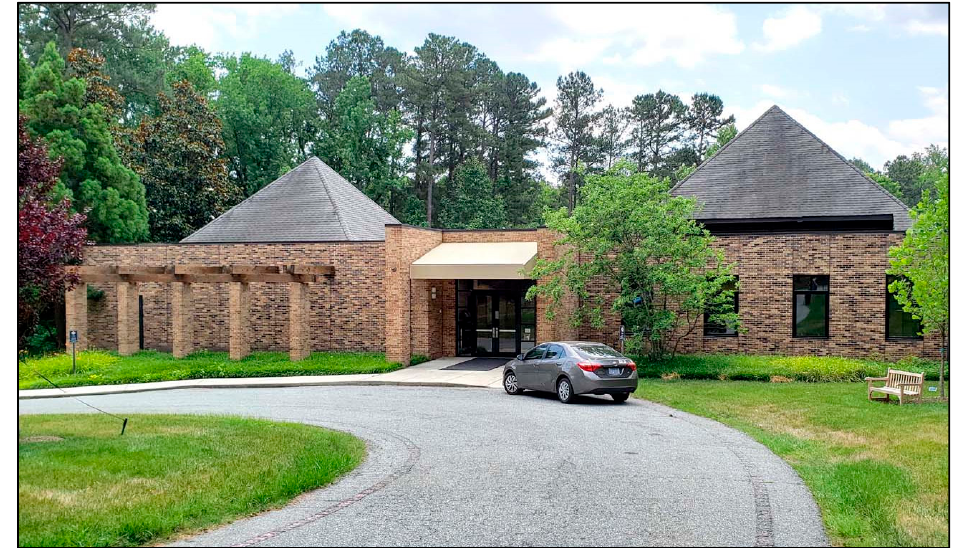
Figure 12. Freeman Center for Jewish Life at Duke, Exterior View from North. Image Credit: © 2019 Jeremy Kargon.